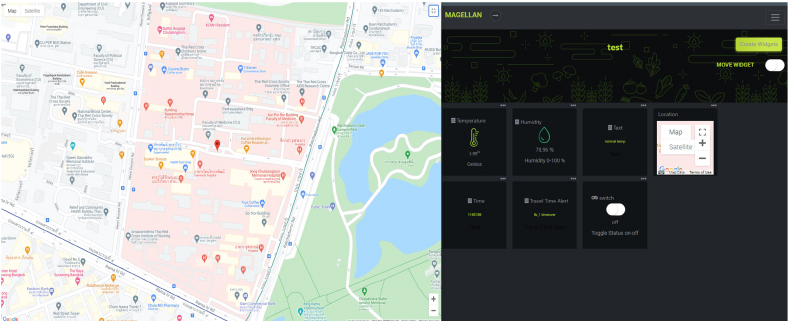
Figure 10. Showing the information of the specimen box during transportation from laboratory A to laboratory B. Table 4. Comparison between our study and related studies in the